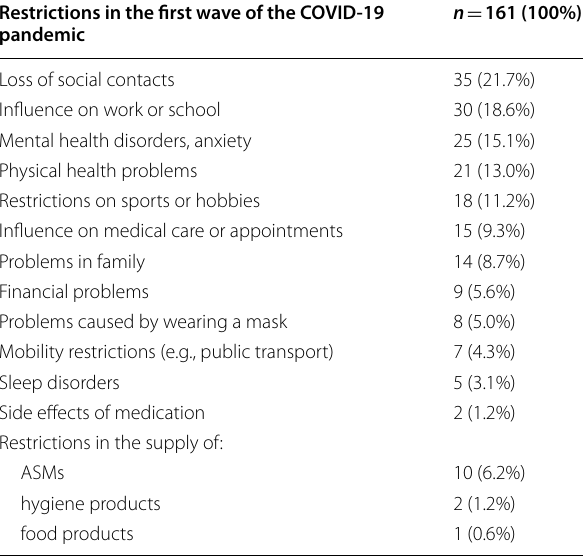
Table 2 Restrictions in the first wave of the COVID‑19